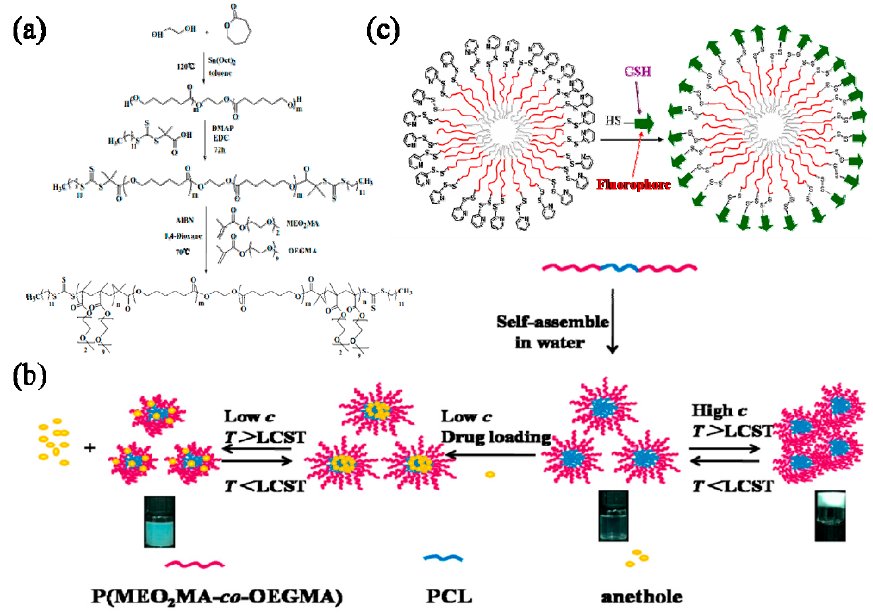
Figure 9. ( a ) Synthesis of triblock copolymer P(MEO 2 MA- co -OEGMA)- b -PCL- b -P(MEO 2 MA- co -OEGMA); ( b ) Schematic representation of the self-assembled thermo-sensitive core–shell micelles for temperature-stimulated drug release and gelation of tPBs. Copyright 2018, Elsevier; ( c ) Functionalized micelles and further attachment of fluorophores and targeting tripeptides.